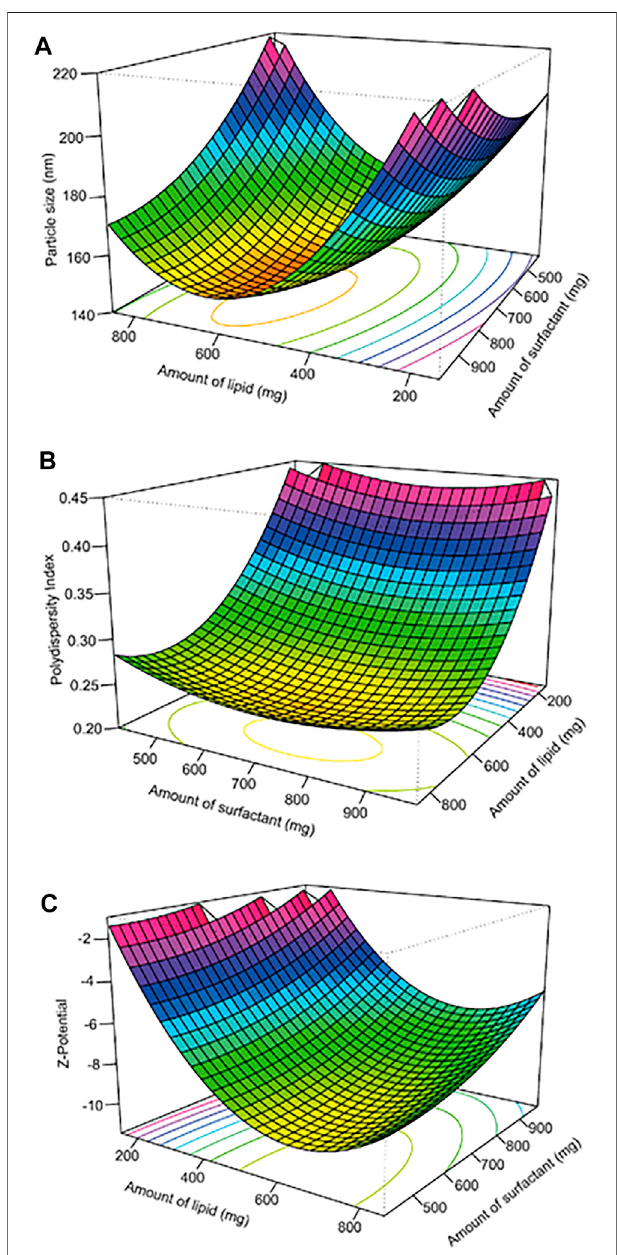
FIGURE 1 | Response surfaces for particle size (A) , PDI (B) , and Z-potential (C) as a function of the amount of lipid (mg) and surfactant (mg).